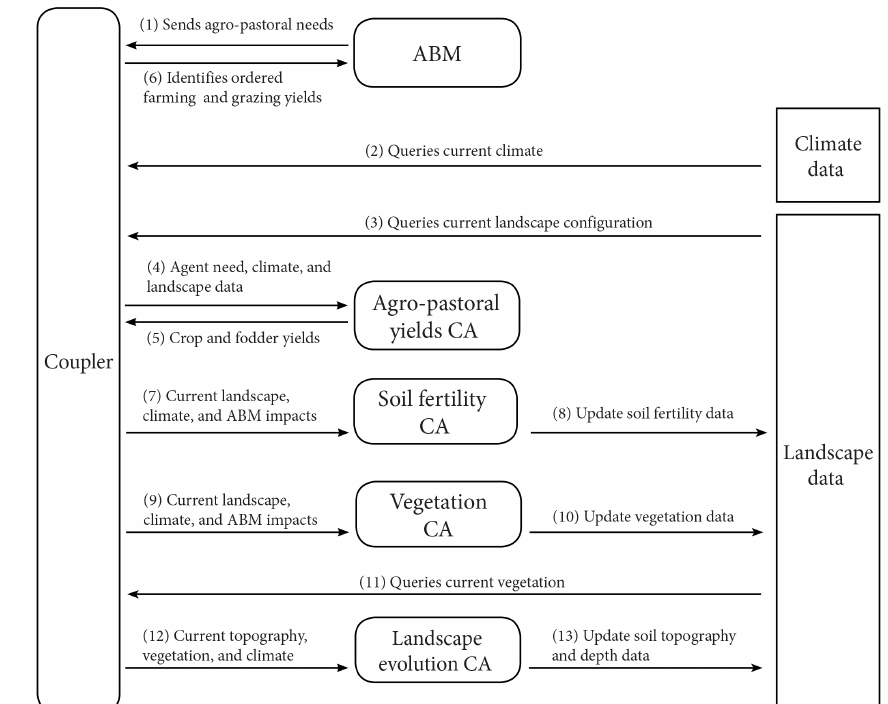
Figure 3. Structure of feedback between the components of the MedLanD Modeling Laboratory, comprising an agent-based model (ABM), several cellular automata (CA) models, data, and a coupler. Numbers indicate the sequence of steps in a single time step of a coupled model